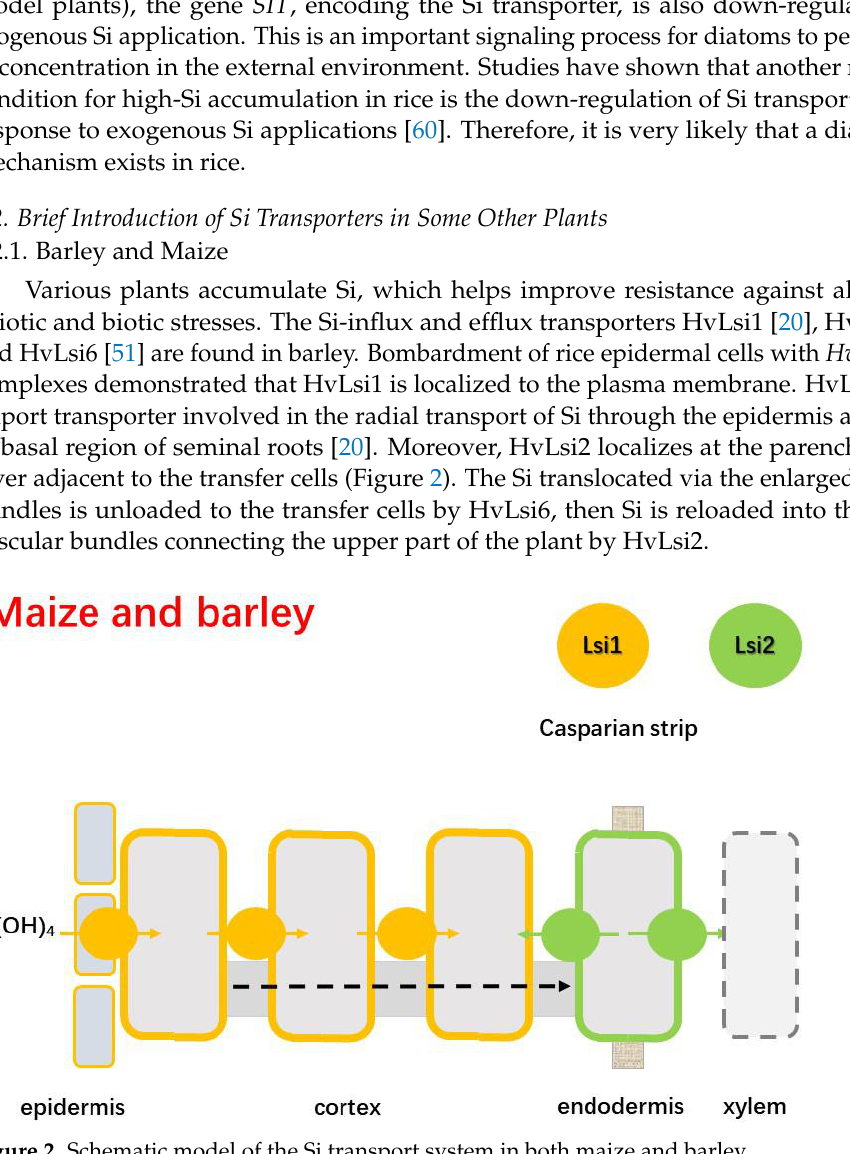
Figure 3. Schematic model of the Si transport system in cucumber.